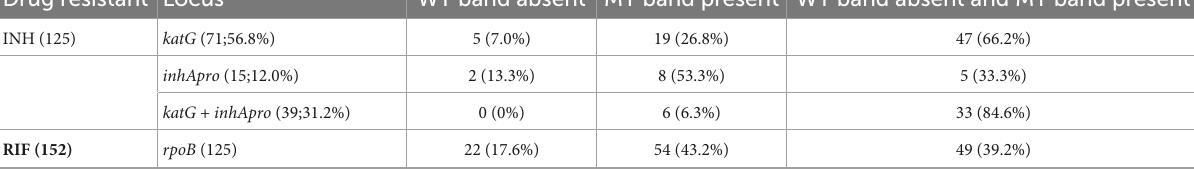
TABLE 2B Observed condensed MTBDR plus band patterns. Drug resistant